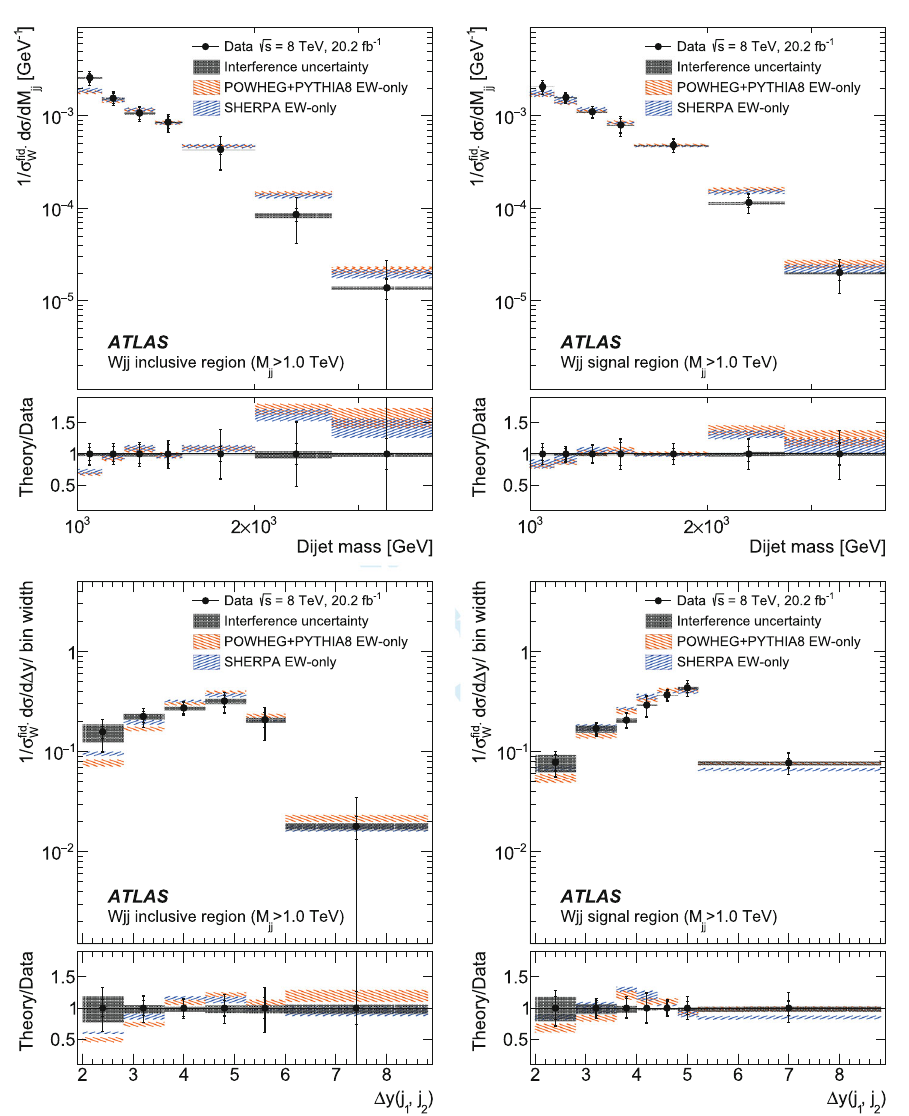
Fig. 19 Unfolded normalized differential EW W jj production cross sections as a function of the dijet invariant mass ( top ) and (cid:6) y ( j 1 , j 2 ) ( bottom ) for the inclusive ( left ) and signal ( right ) fiducial regions with